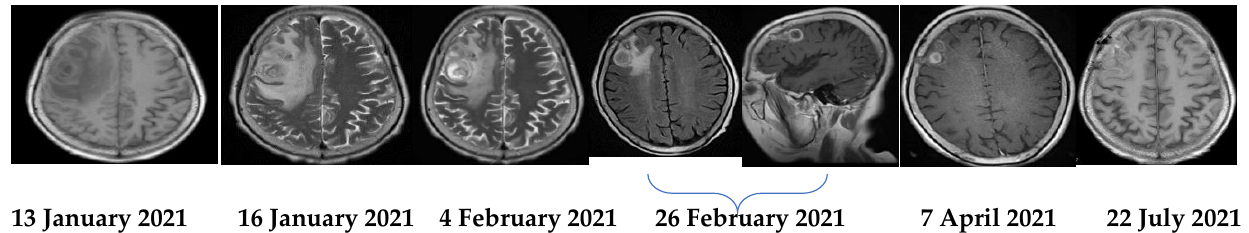
Figure 3. Serial MRIs during the treatment course.